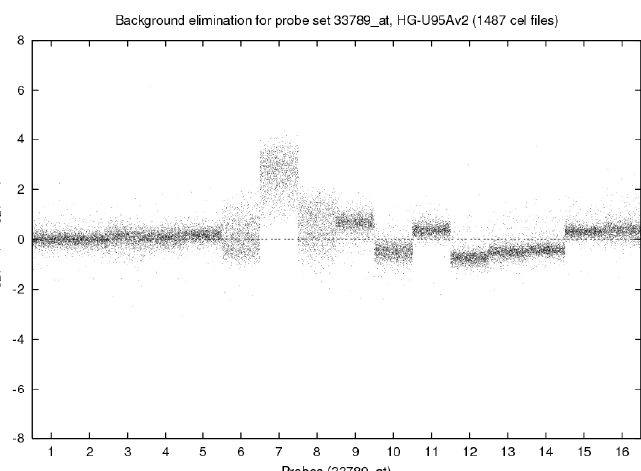
Supplementary Figure 1: Probe intensities over all cel files for probe set 33789 at on the HG U95Av2 array (A) Perfect match intensities (log scale) (B) ADAPT probe positions on the transcripts (C) Background elimination (log 2 (PM) - log 2